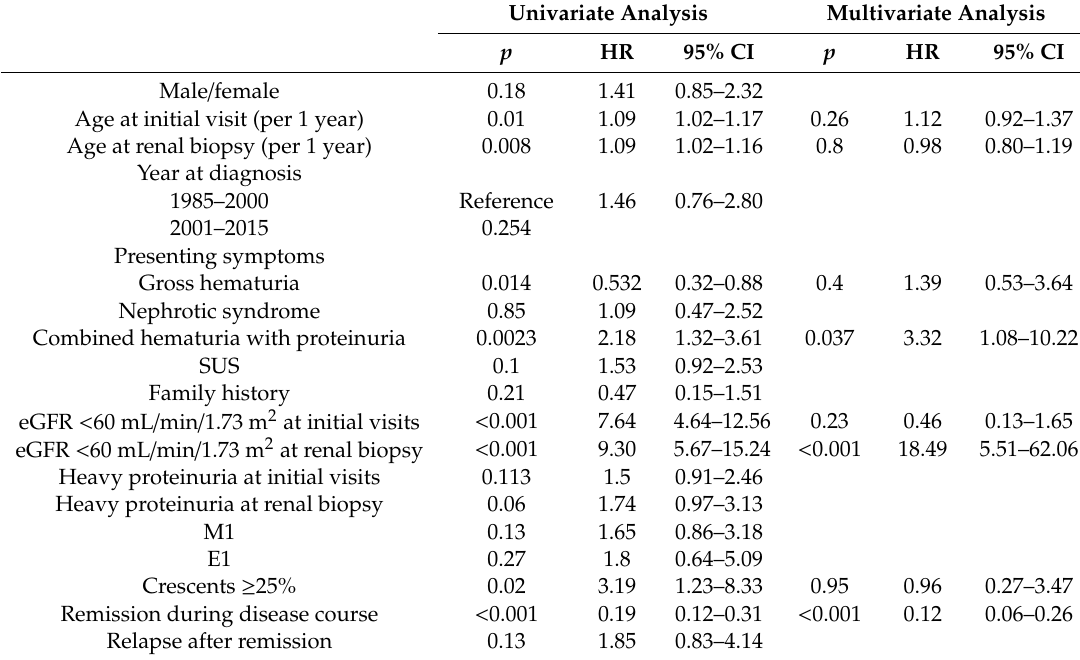
Table 2. Risk factors associated with progression to